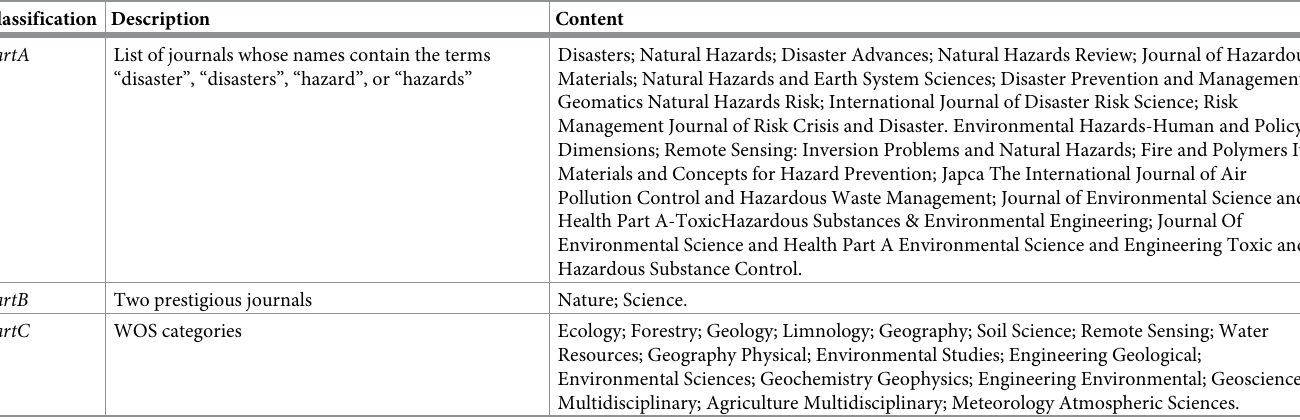
Table 1. List of three criteria used for retrieving natural disaster